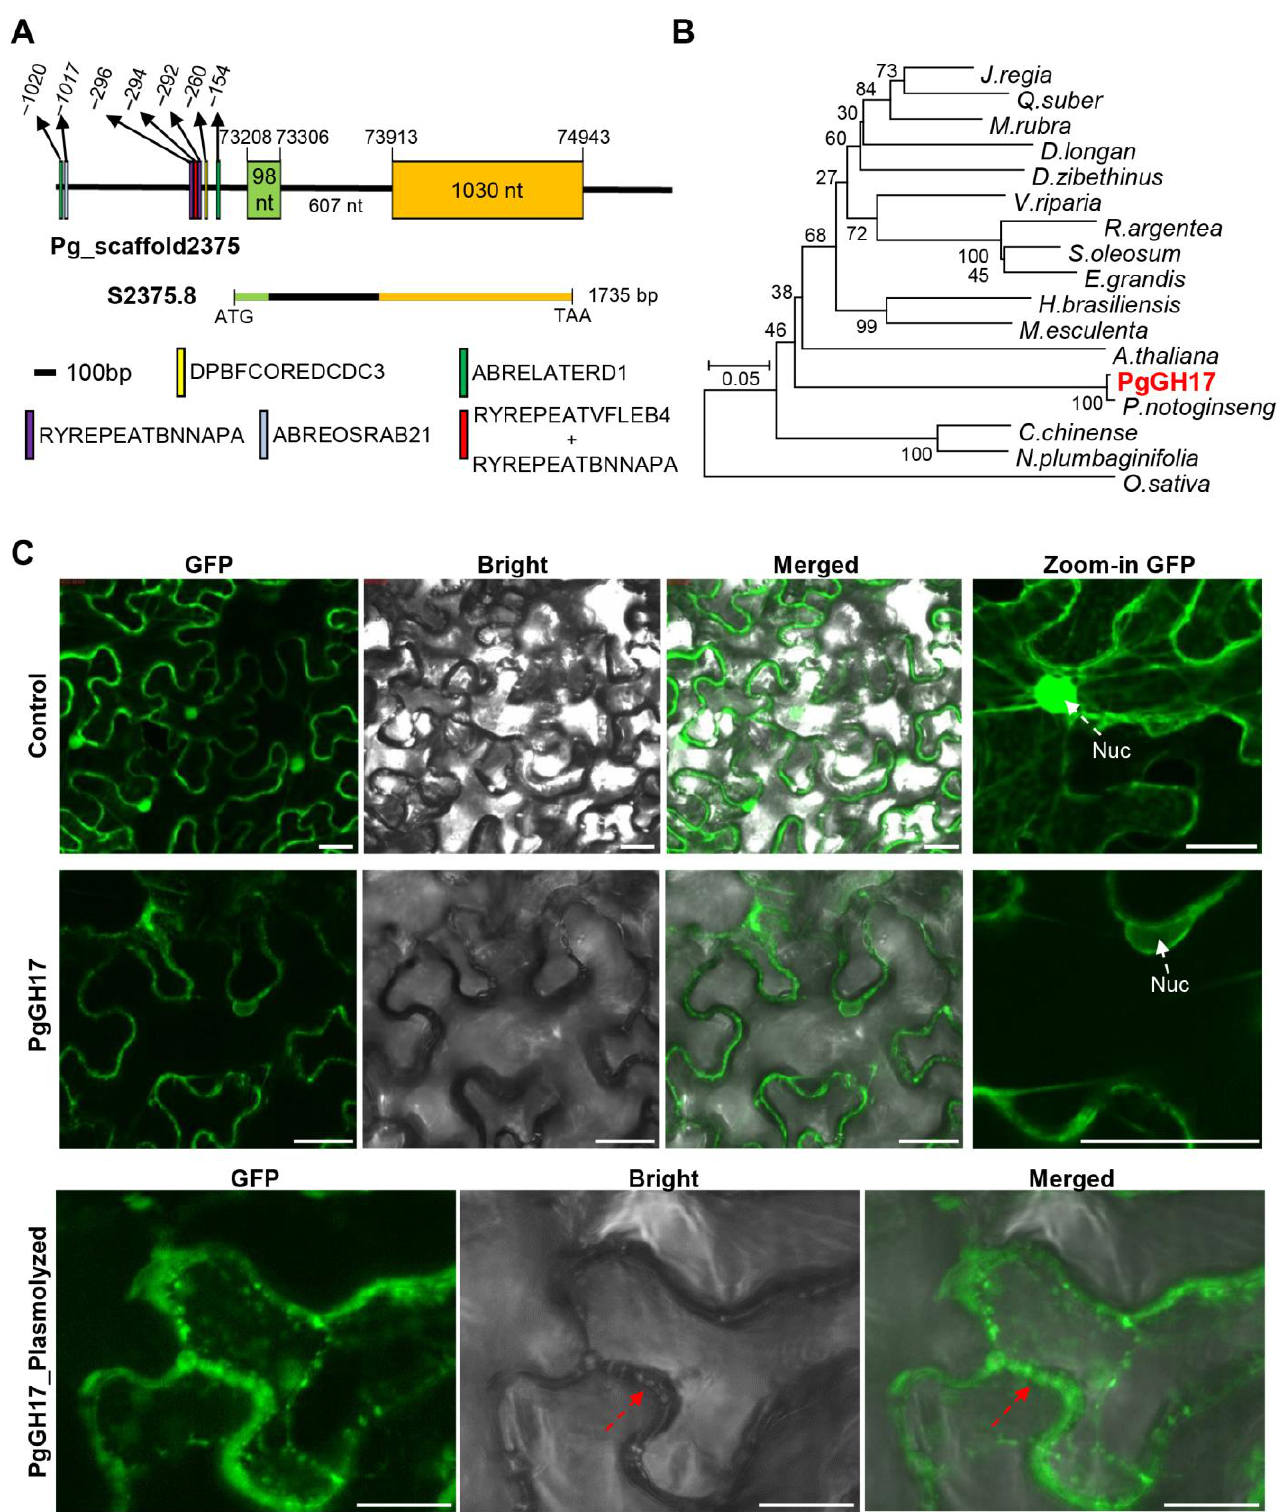
Figure 5. Cloning and overexpression of PgGH17 in Arabidopsis . ( A ) Gene structure of PgGH17 in the ginseng genome. ( B ) Phylogenetic analysis of PgGH17. The PgGH17 protein and homologous proteins from various plants, including Juglans regia (XP018825764.1), Quercus suber (XP023873688.1), Morella rubra (KAB1213853.1), Durio zibethinus (XP022760689), Dimocarpus longan (AKE49478.1), Hevea brasiliensis (XP0216687), Manihot esculenta (XP02160835), Vitis riparia